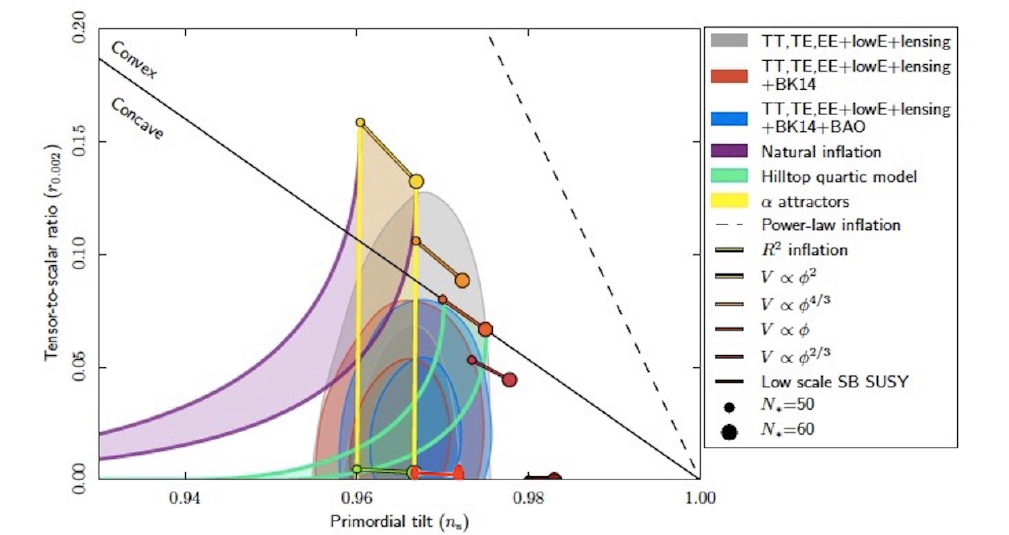
Figure 15 . ( n s ; r )-plane for various in(cid:13)ationary models (taken from [7]) with the predictions for the Starobinsky-like in(cid:13)ationary model superimposed through the (lower) red line, for parameter choice m = 7 : 20 (cid:2) 10 11 GeV and 7 : 75 (cid:2) 10 (cid:0) 11 . (cid:21) . 1 : 05 (cid:2) 10 (cid:0) 10